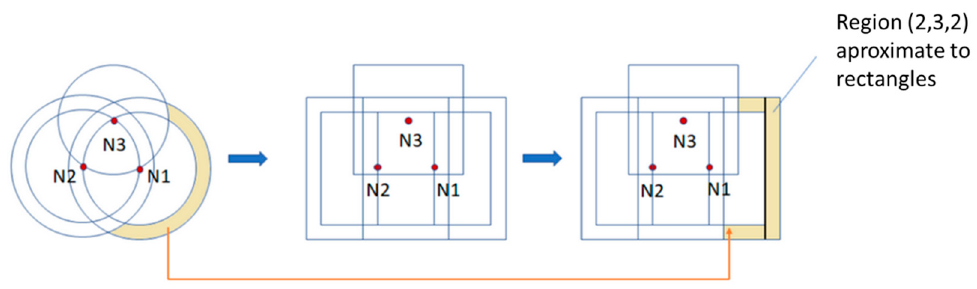
Figure 9. Approximation of a region by rectangles.